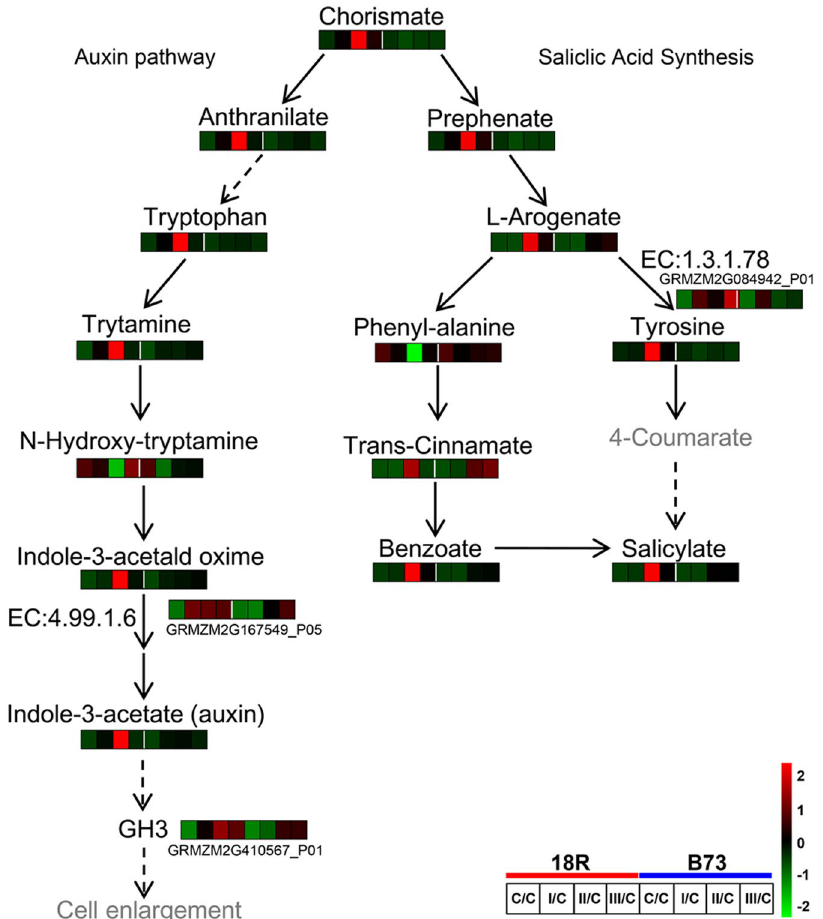
Figure 5. Auxin- and salicylic acid-related pathway changes induced by induction medium. The heatmap represents the metabolite and DEP abundance at different stages of 18R and B73. The dashed arrow represents multiple reaction steps.